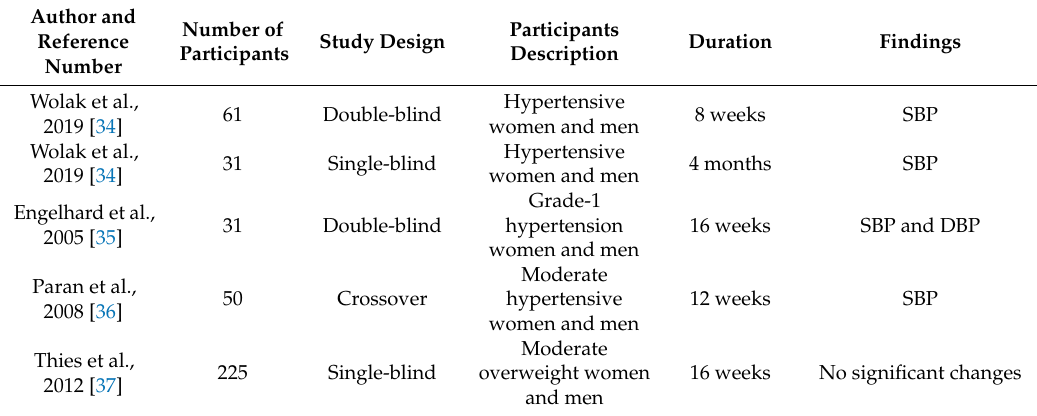
Table 2. Comparison of